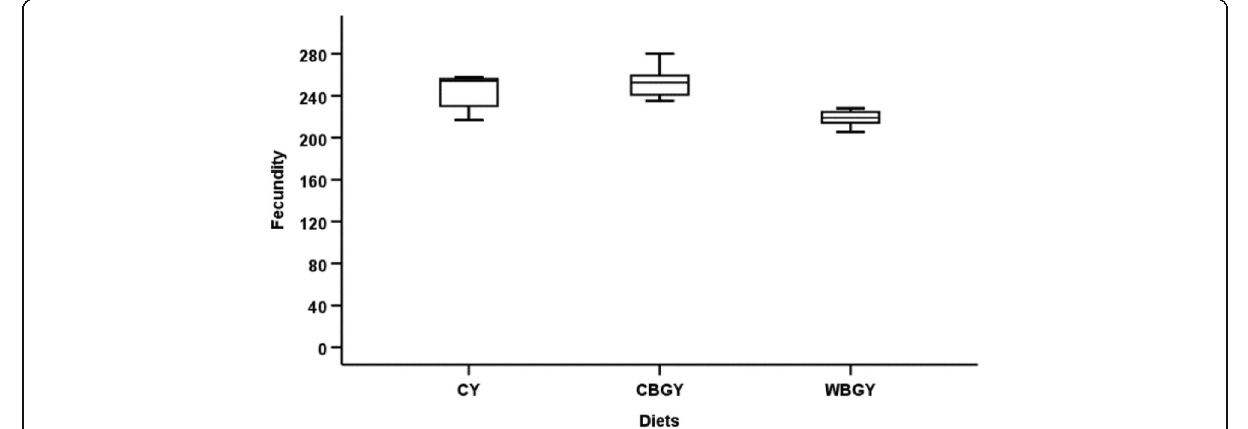
Fig. 1 Number of the eggs laid by Ephestia kuehniella feeding on three